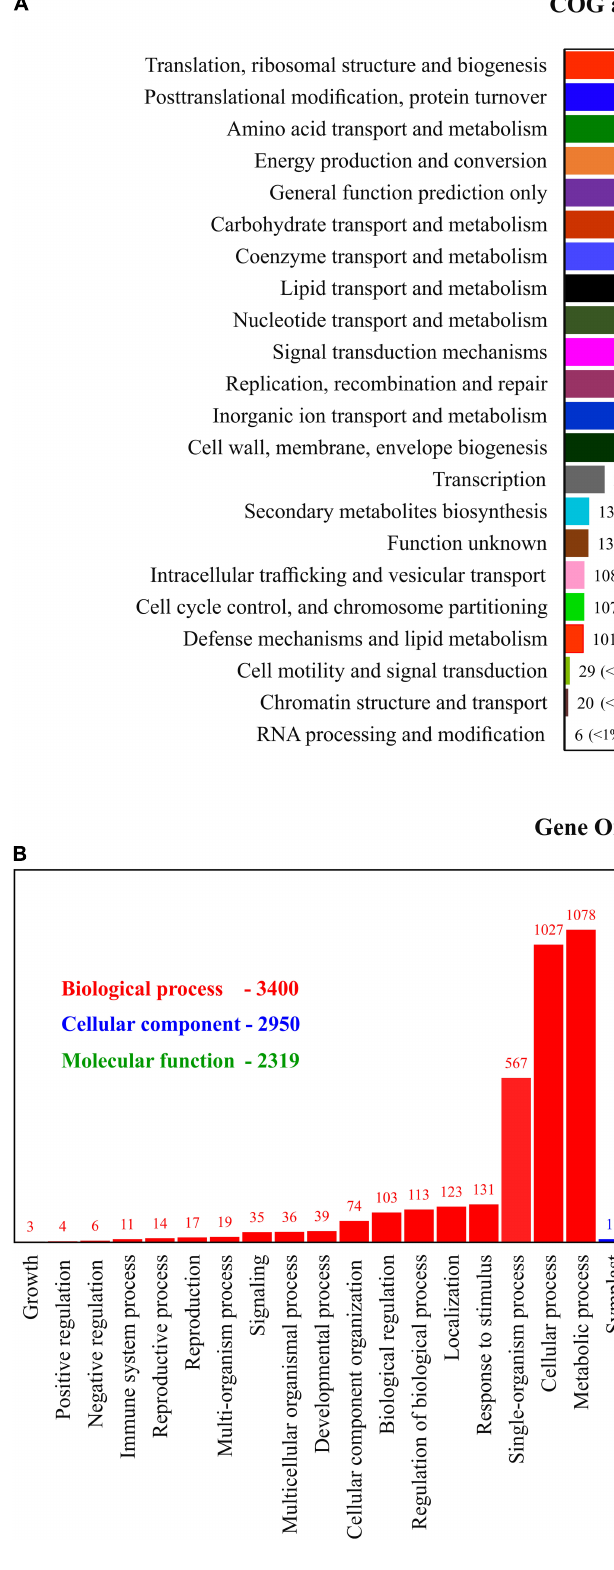
Frontiers in Plant Science |